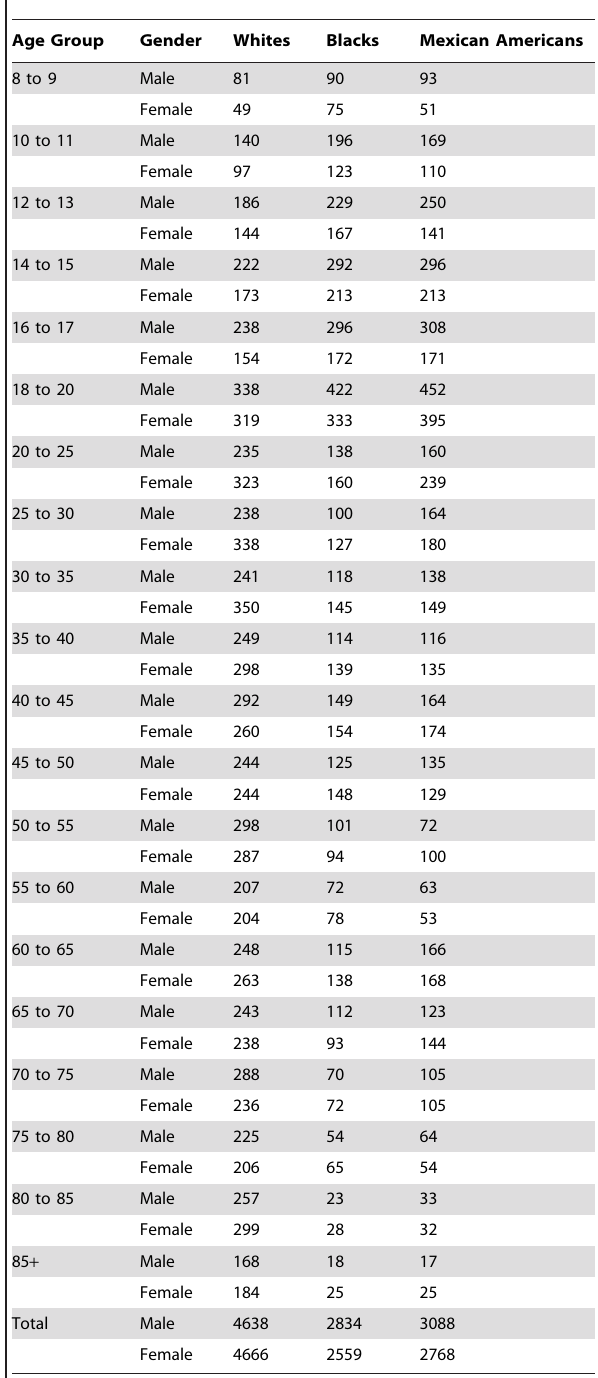
ethnicity using age as the independent variable. Whole body fat and lean mass measurements and appendicular lean mass were normalized to height 2 as suggested by Heymsfield et al. [11]. Table 1. Number of observations in the reference database by age, gender, and